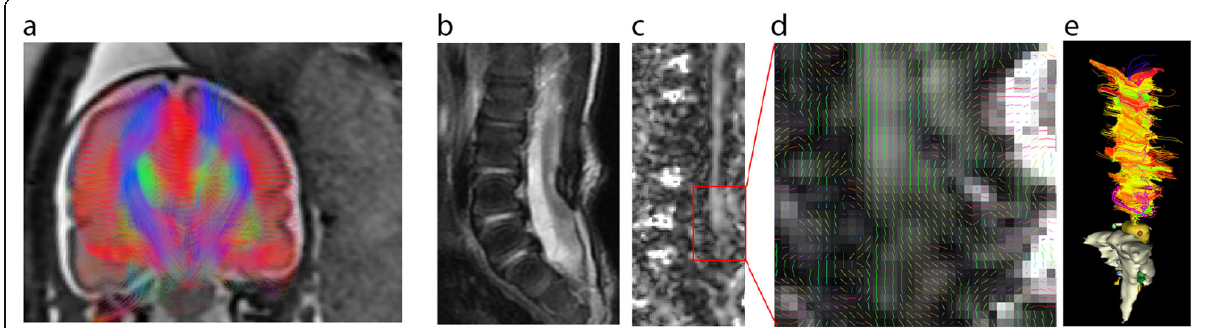
Fig. 2 Diffusion tensor imaging in spinal dysraphism. a Diffusion tractography of a foetus with spinal dysraphism, 26th week of gestation. The fibre tracts (colour representing spatial orientation) have been overlaid on a coronal plane, T2-weighted MR image. b Sagittal T2-weighted MRI of a newborn with spina bifida, corrected prenatally, showing signs of tethered cord. c Sagittal fractional anisotropy image of the same myelon cross-section, demonstrating increased anisotropy in the region of the tethering. d Diffusion tensor principal vector orientations in the same region. e Diffusion tractography of the